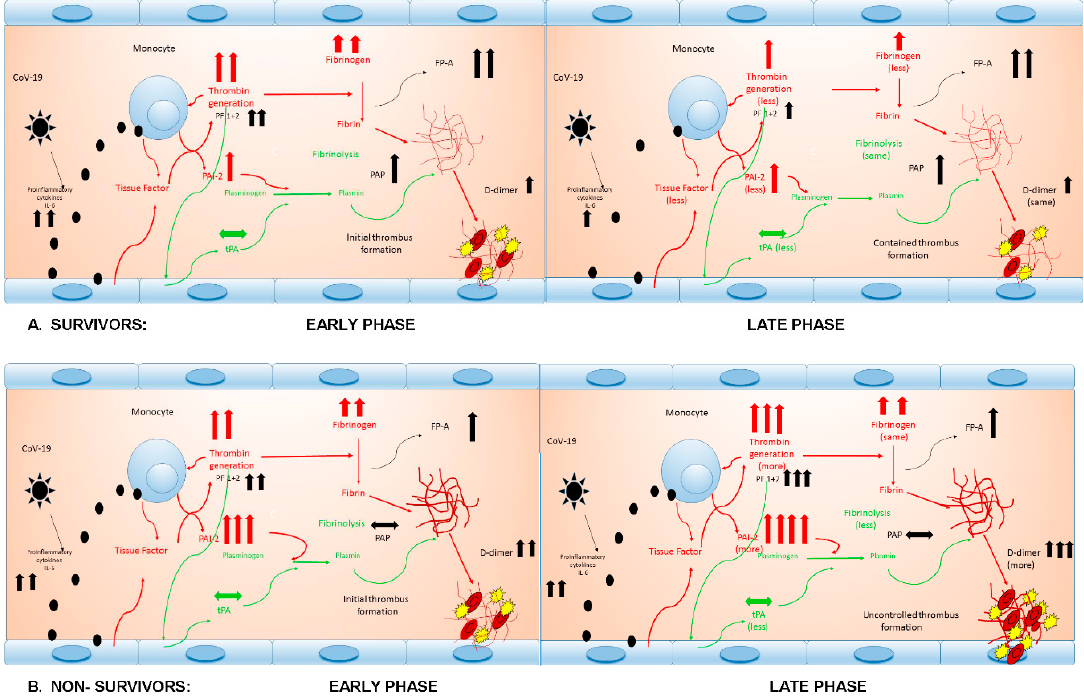
Figure 3. The chain of inflammatory and hemostatic reactions in survivors ( A ) and nonsurvivors ( B ), from early to late phase. FP-A: fibrinopeptide A; IL-6: interleukin-6; PAI-2: plasminogen activator inhibitor 2; PAP: plasmin–antiplasmin complex; PF 1 + 2: prothrombin fragment 1 + 2; t-PA: tissue plasminogen activator. Red lines are prothrombotic; green lines are antithrombotic.